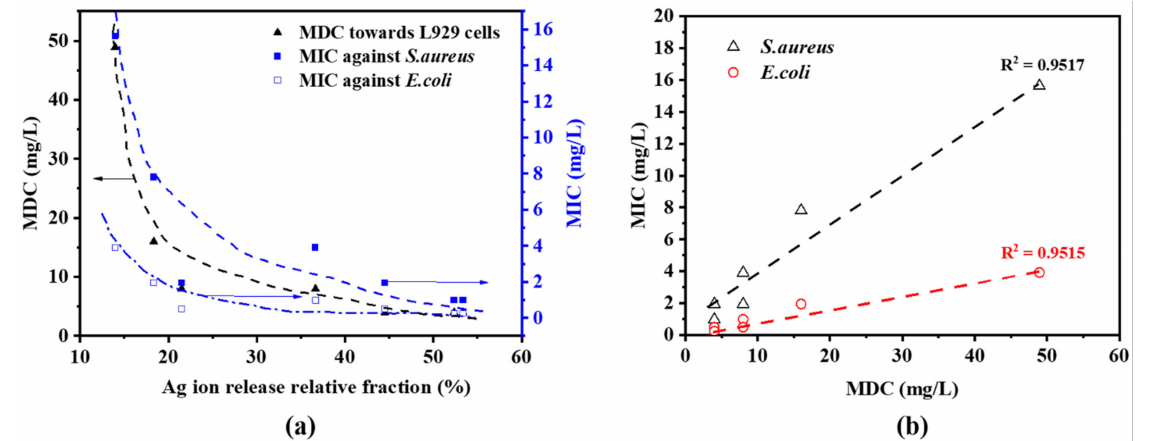
Figure 9. ( a ) MIC and MDC variations with released Ag + fractions for Ag, AgCu and AgFe. ( b ) MIC values as a function of the MDC values for Ag, AgCu and AgFe.